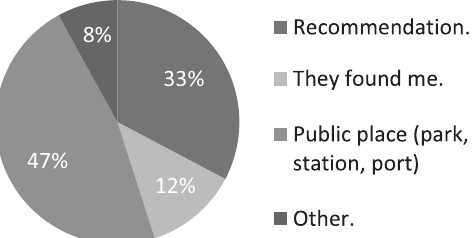
Figure 1. Means of finding smuggler. Note: Means re- sponses also included “Internet,” which 0 respondents selected; “Other” included fill-in-the-blank option: an- swers included “By luck,” “By chance,” “Accidentally.”).